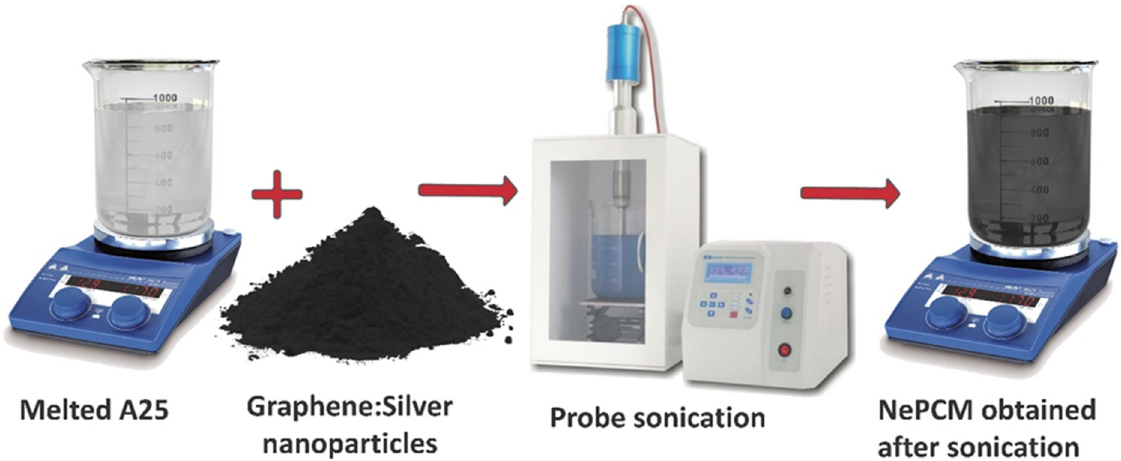
Figure 1. Synthesis route of hybrid nanocomposites.